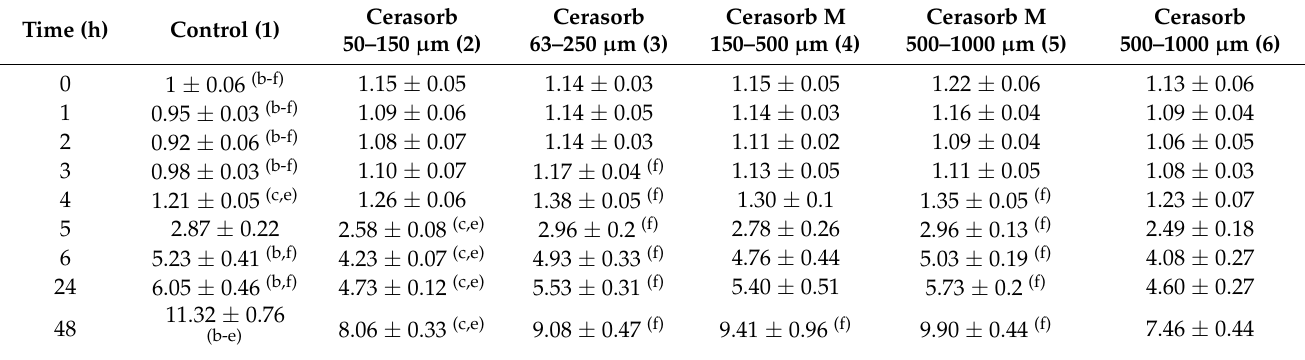
Figure 1. Cell viability of primary osteocytes (osteoblasts?) growing on bone substitutes. After seeding cells on the individual bone materials cell viability was measured using alamar blue viability test kit. Significant differences in cell growth can be detected comparing the growth of the control cells to the growth of cells in the presence of different bone substitutes and between the different bone substitutes (= interindividual differences). Stars mark significant differences in osteoblast growth between the groups and rhombus show significant differences in osteoblast growth between different bone substitutes (= intraindividual differences). Table 1. Proliferation of osteoblasts. The individual values of the alamarblue ® proliferation assay are listed below.